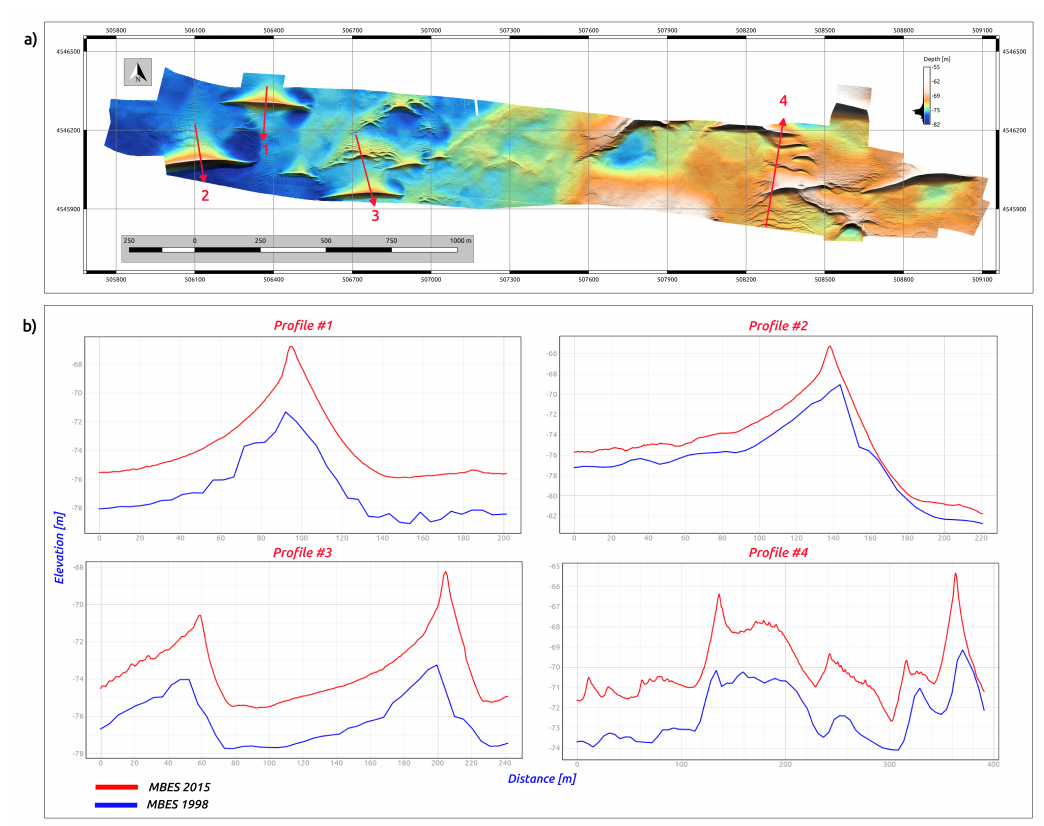
Figure 35. Vertical profiles ( a, b ) comparing the two MBES dataset collected in 1998 (blue, cell size: 9m), and 2015 (red, cell size: 1m). Lines numbered 1–4 in ( a ) indicate the transect used to plot the vertical profiles in ( b ). A constant vertical offset of about 1 m can be seen, attributed to differences in accuracy and resolution of the data acquisition systems used in the two